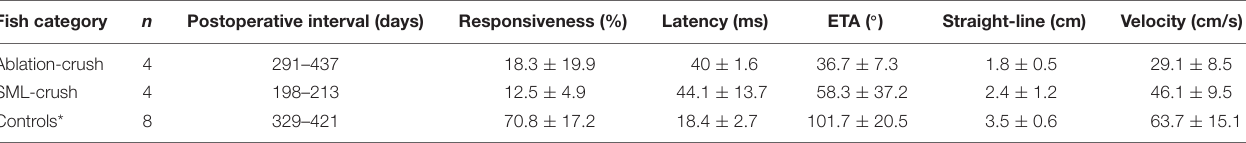
TABLE 3 | Comparison of startle response parameters between ablation-crush and SML-crush fish. Fish